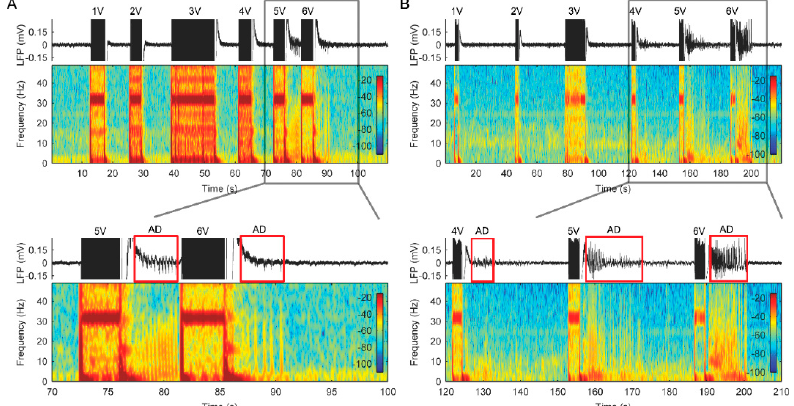
Figure 2. The use of a test tone to monitor the integrity of the bioelectric amplifier in measuring local